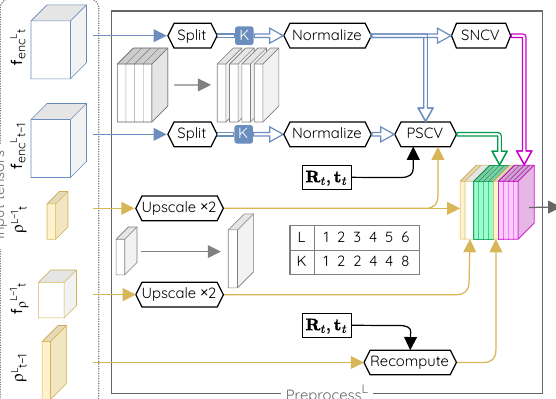
Figure 3. Details of the operations performed by our preprocessing units. Its building blocks do not feature any learnable parameters; they are detailed in Section 4.2. The split layer subdivides feature vectors in K sub-vectors to be processed in parallel in subsequent steps. We give the value of K that we use for an architecture with six